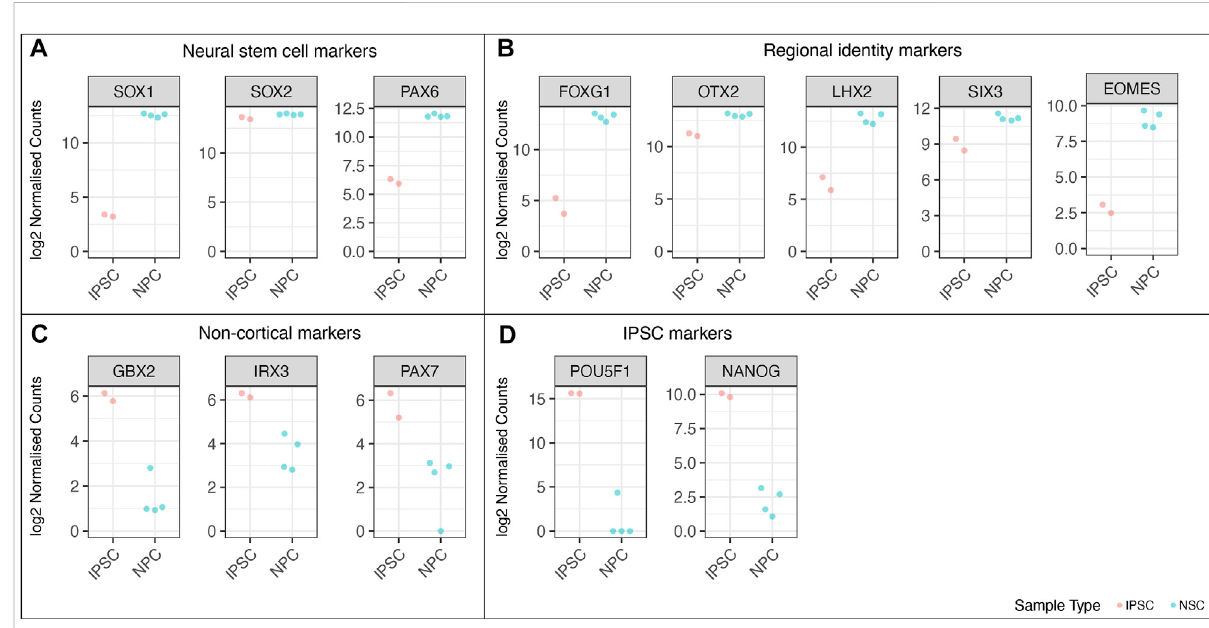
FIGURE 9 RNA-Seqanalysisofthewild-typecelllinesfromtheMED13Lgeneset,comparingundifferentiatediPSClinestodifferentiatedneuralstemcells. Log2 normalised read counts of (A) neural stem cell markers, (B) markers of cortical regional NSC identity (C) non-cortical markers, and (D) pluripotent stem cell markers. Note that there are four samples for NSCs and two iPSC samples, because each cell line was split into two technical replicates immediately prior to